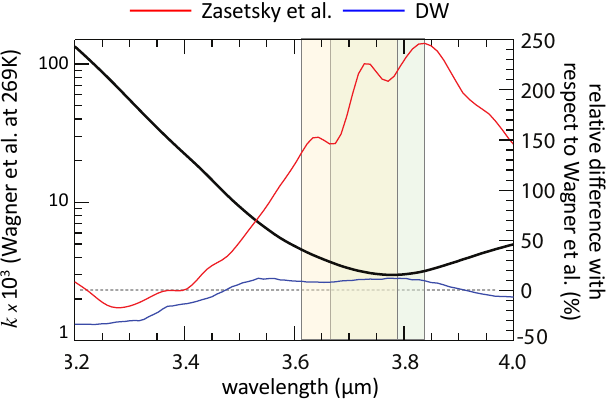
Figure 2. Similar to Figure 1 but for the 3.7 µ m MWIR atmospheric window and the Wagner et al. 269 K dataset. Di ff erences in k relative to Wagner et al. are shown for the datasets of DW at 300 K and Zasetsky et al. at 263 K. The nominal half-power bandpasses for the most relevant MODIS (green shading) and VIIRS (yellow, [35]) channels are also shown.